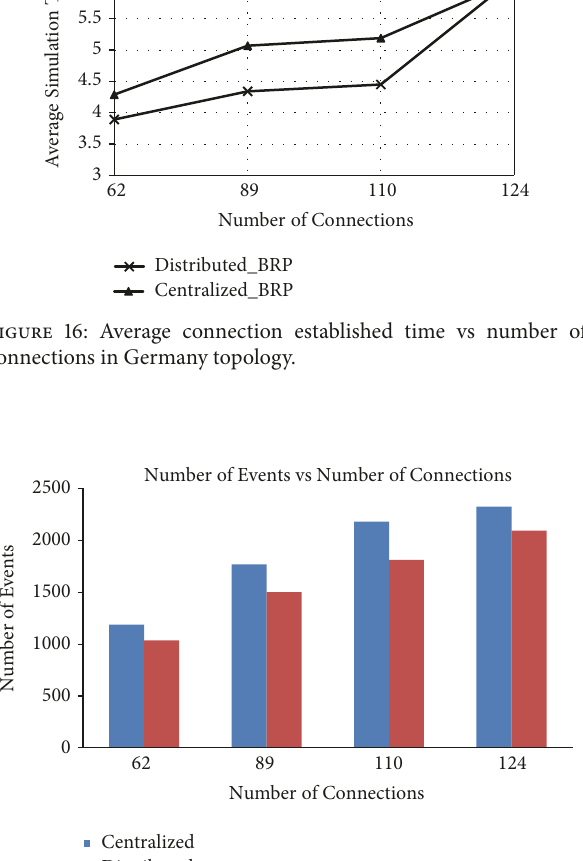
Figure 20: Random Fit with BRP and Poisson